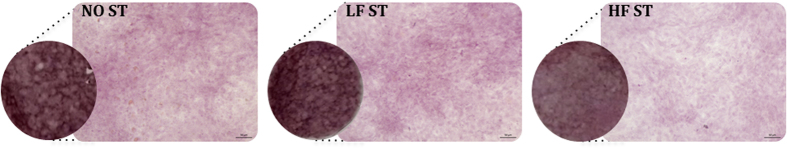
Visual analysis of the matrix mineralization in MC3T3 cells exposed to EMFs generated by LF EX and HF EX for 21 DIV.Fixed cells in 35 mm culture plates were subjected to cytochemistry procedures with Alizarin Red, which marks calcified extracellular matrices. Photographs of representative Alizarin Red-stained circular plates are shown, together with zoomed in insets taken with a light microscope under a 10x objective (right rectangles). Bar, 50 μm.